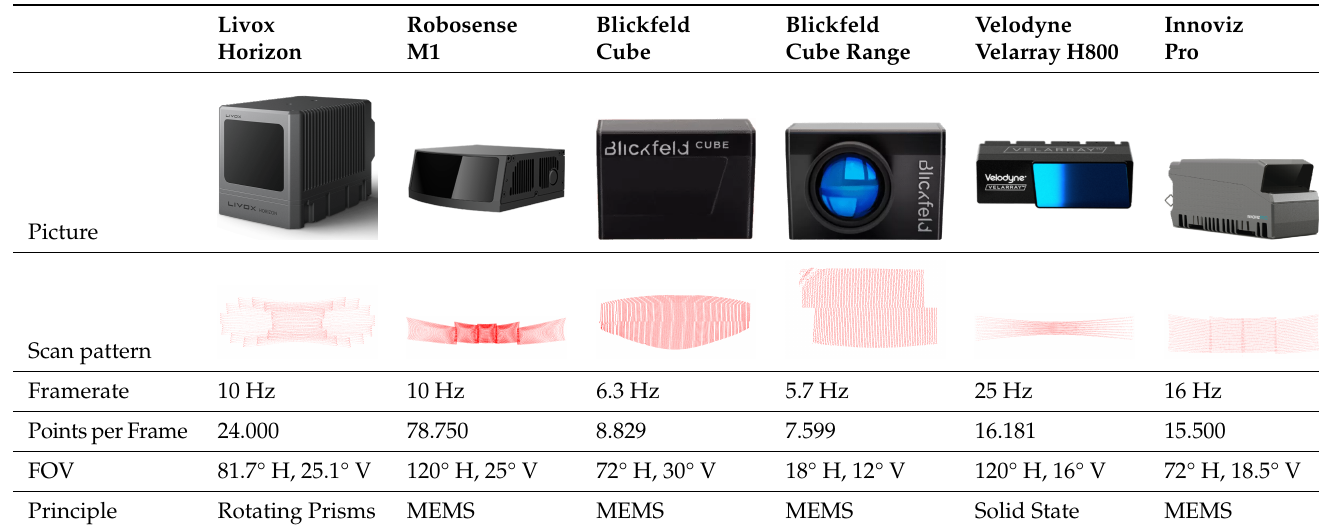
Table 1. The tested sensors with their respective scanning patterns. The pictures of the scan patterns were made by facing the LiDAR toward a white wall. The screenshots were taken in the point cloud viewer from the LiDAR